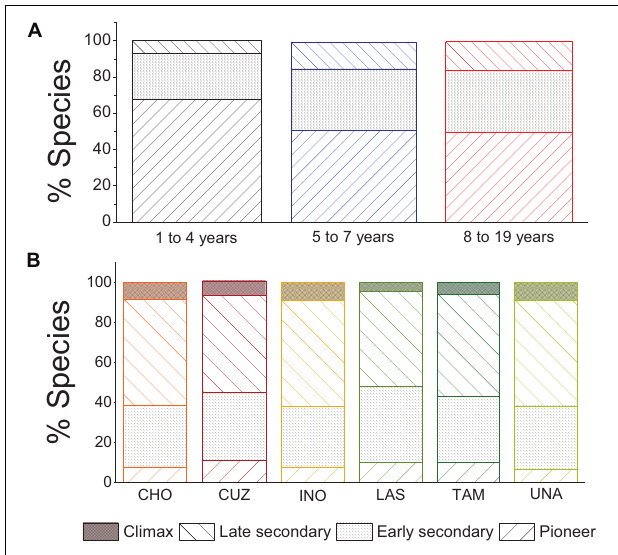
FIGURE 3 | Percentage of species by successional status in abandoned mining plots (A) and reference plots (B) . UNA, Forest of the Universidad Nacional Amazonica de Madre de Dios; INO, Inotawa; CHO, Chonta; TAM, Tambopata plot zero; LAS, Jacaralia Los Amigos; CUZ, Cuzco Amazonico.